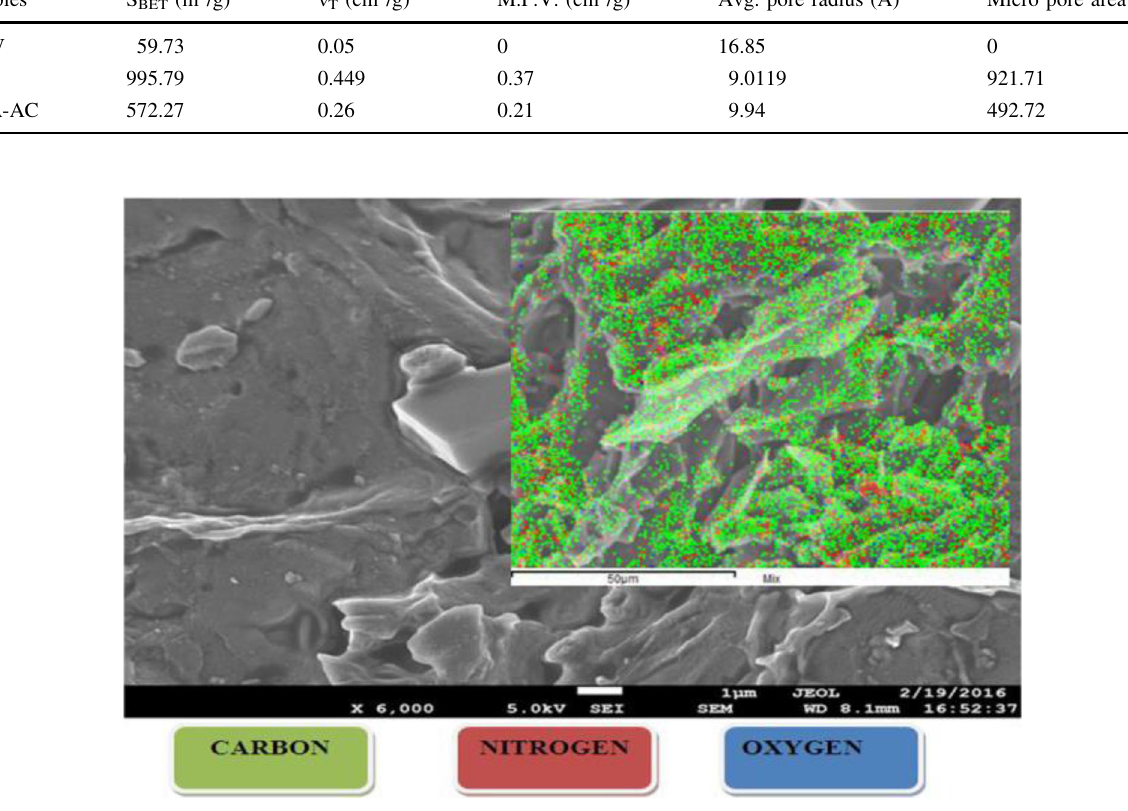
Table 8 BET surface area and pore size distribution (at optimum condition) Samples